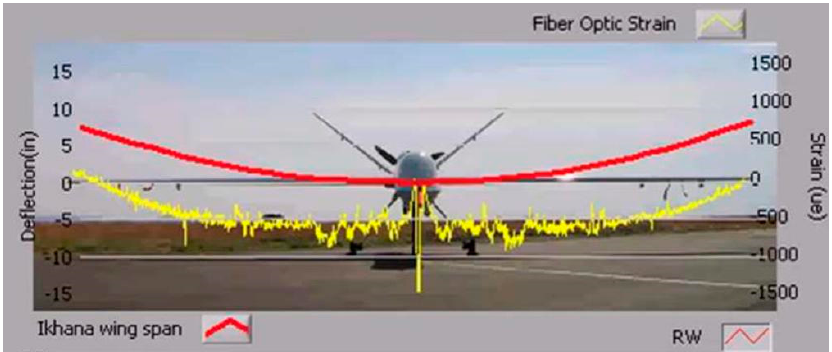
Figure 2. Real-time aircraft wing shape measurement using fiber optics sensors [3].